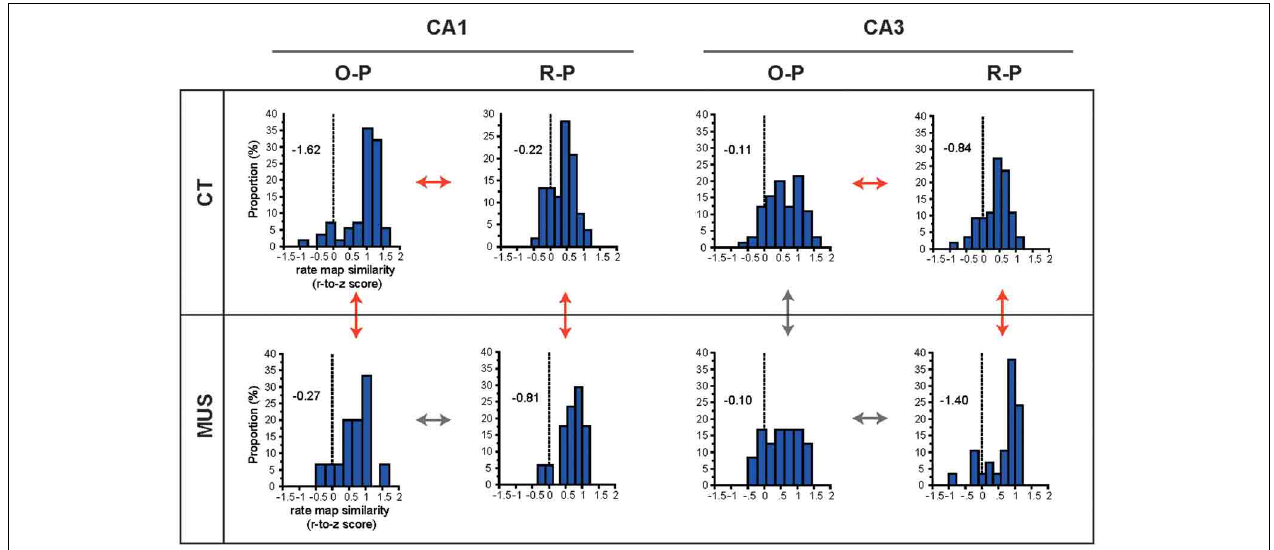
FIGURE 6 | O-P and R-P firing patterns in hippocampal subfields. The distributions of r-to-z transformed scores of correlation coefficients between firing rate maps for different trial types (i.e., O-P and R-P) are presented for the combinatorial conditions between